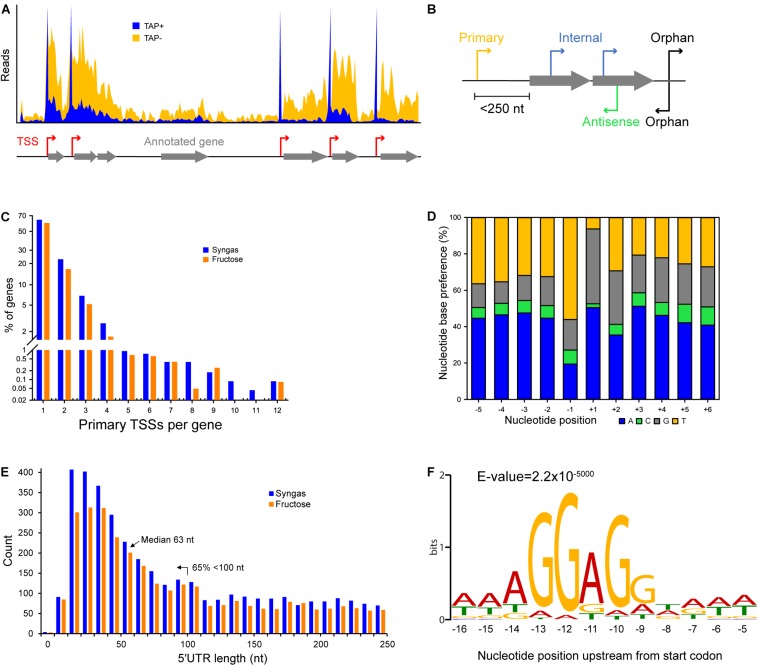
Characteristics of transcriptional and translational architecture in C. autoethanogenum. (A) Our dRNA-Seq approach generated genome-wide TSS maps through the comparison of libraries enriched for processed (TAP–) and primary (TAP+) transcripts. (B) Classification of TSSs for syngas and fructose as: primary, within 250 nt upstream of an annotated gene; internal, within an annotated gene; antisense, on the opposite strand of an annotated gene; orphan, not assigned to any of the previous classes. (C) Distribution of primary TSSs per gene for syngas and fructose. (D) Nucleotide base preference for transcription initiation from primary TSSs on syngas. +1 denotes the position of the TSS. (E) Distribution of 5′UTR lengths for primary TSSs for syngas and fructose. (F) The Shine-Dalgarno sequence AGGAGG is highly conserved within 9–14 nt upstream of the first start codon. Sequencing reads were processed with the TSSAR software (Amman et al., 2014) for automated de novo determination of TSSs from dRNA-Seq data using the following parameters: p-Value 1e-3, Noise threshold 10, Merge range 5. The Shine-Dalgarno sequence was searched 30 nt upstream of annotated genes (CP006763.1 and NC_022592.1) using the MEME software (Bailey et al., 2009) and the same parameters as for promoter motif search, except for -nmotifs 10, -maxw 30. See section Materials and Methods for details.